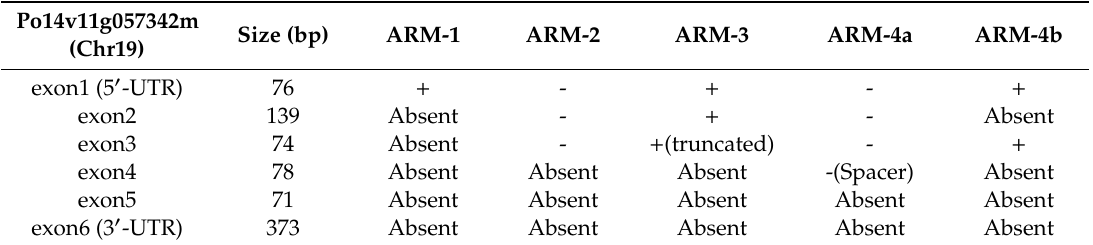
Table 5. Fragments of response regulator genes in inverted arms compared to the complete paralogous gene